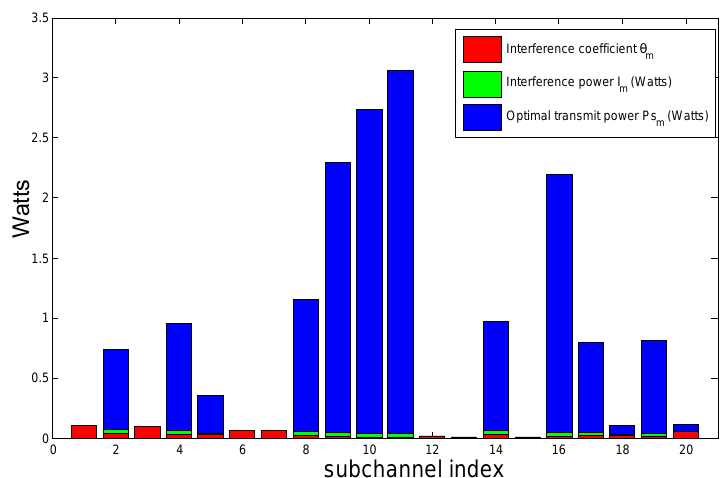
Figure 2. Schematic diagram of PLC system interference coefficient, optimal interference power value and optimal power allocation value.